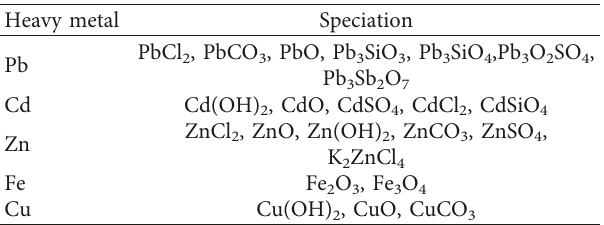
Table 3: MSWI fly ash immobilized with different cementitious matrix